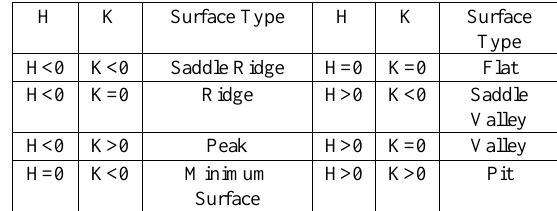
Table 1. Surface classification based on sign of H and